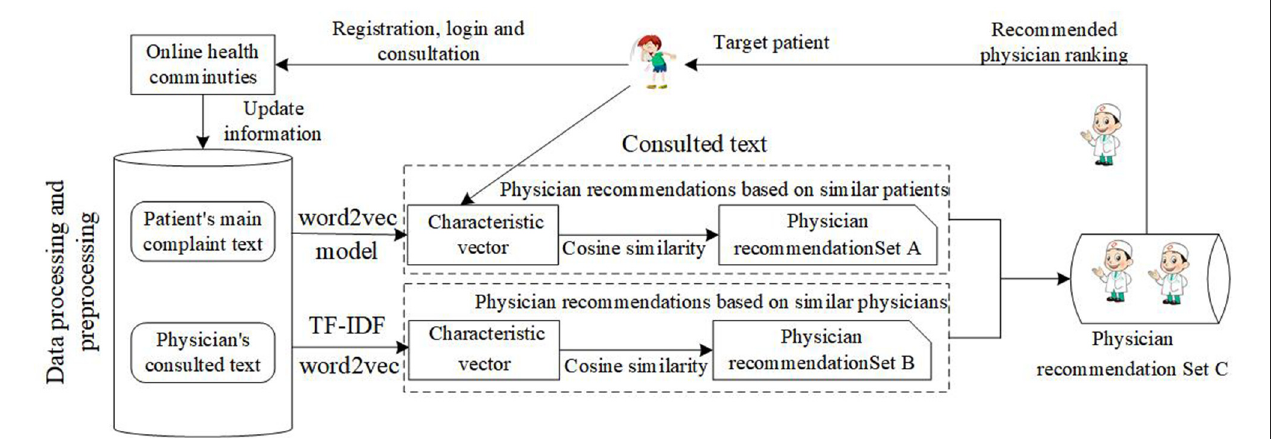
FIGURE11 Intelligent physician recommendation